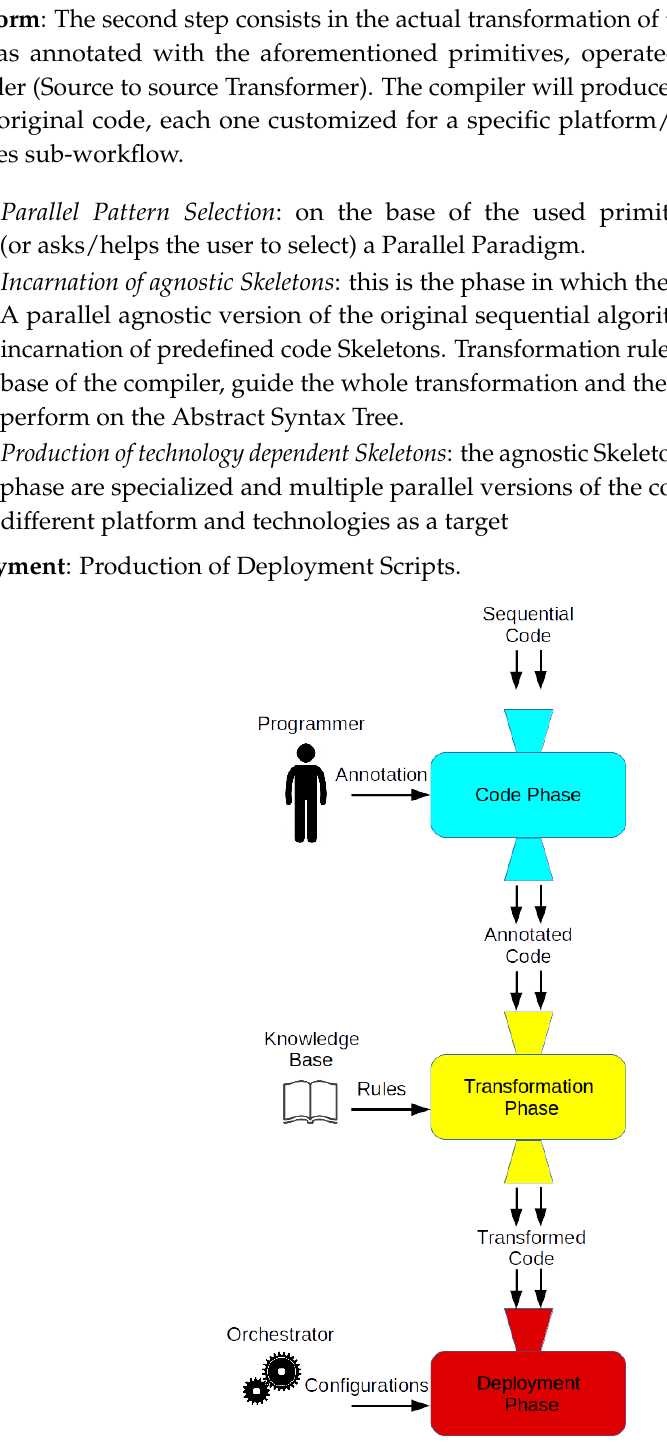
Figure 1. The Code-Based Approach